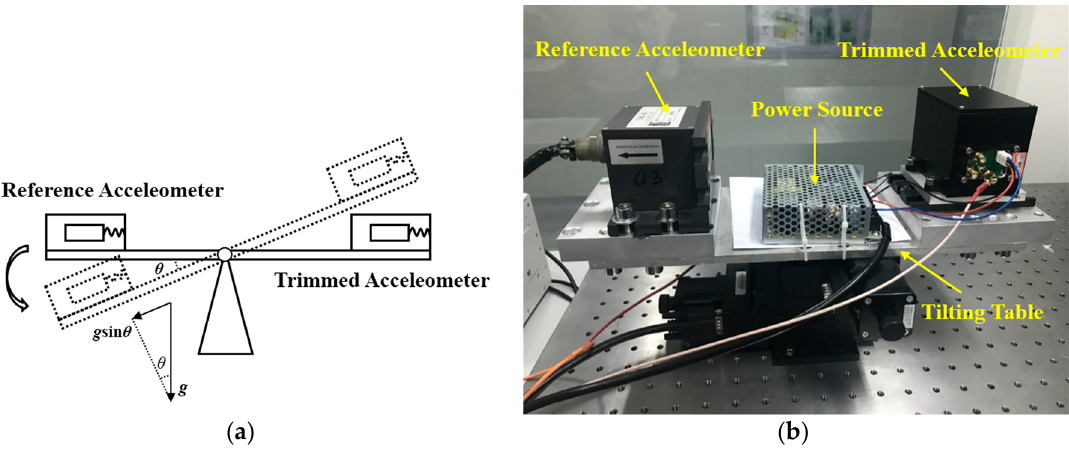
Figure 3. The calibration system. ( a ) Principle of the calibration with the tilting method. ( b ) The setup of the calibration system.